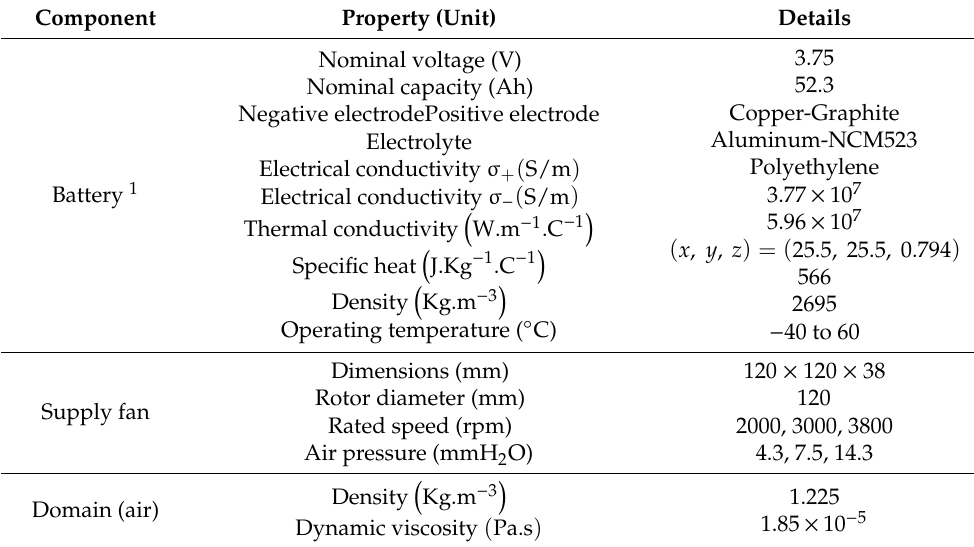
Table 1. The specifications of the battery cell, supply fan, and fluid